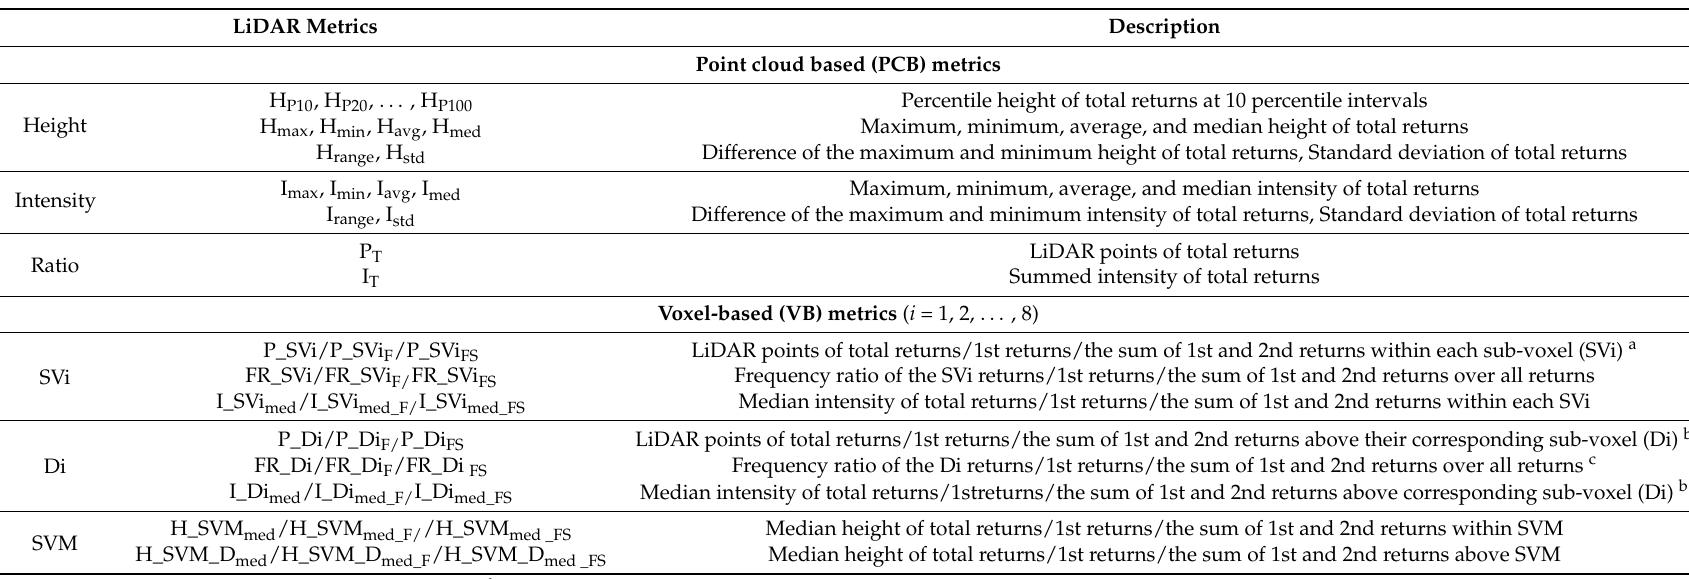
Table 2. Description of LiDAR point cloud based (PCB) metrics and voxel-based (VB)